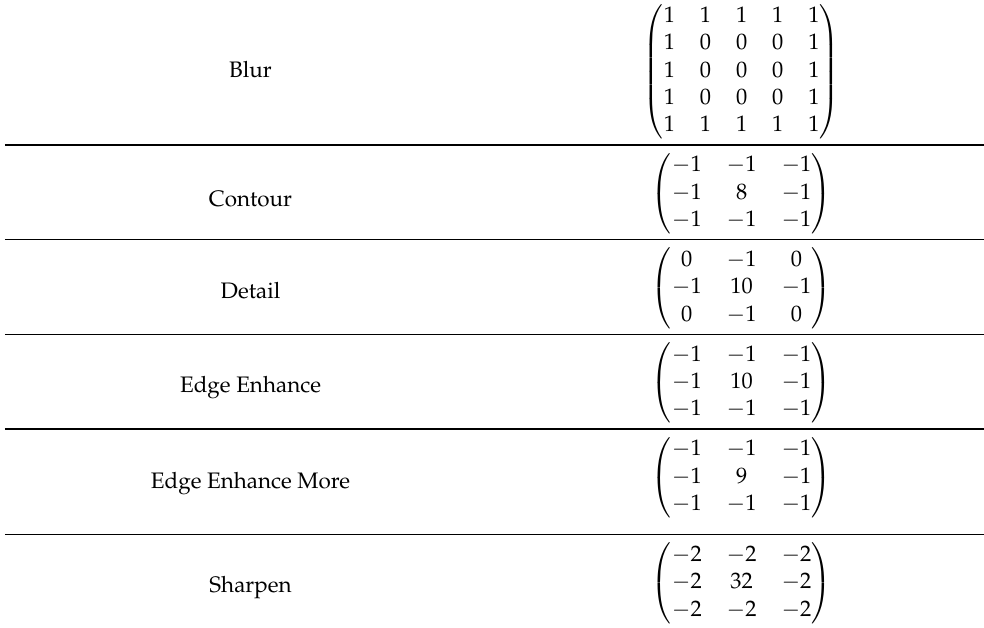
Table 2. Convolution Kernel